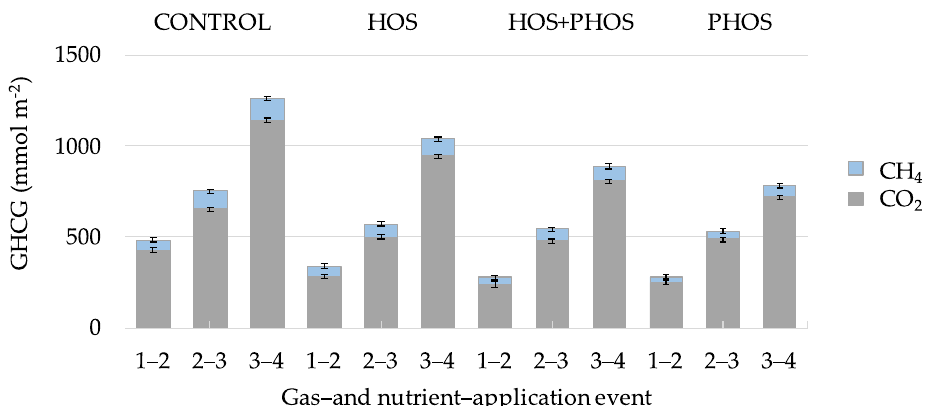
Figure 4. Emissions of CO 2 and CH 4 from experimental reactors from one gas- and nutrient application event to another. [Sed] = 14.1 g (dw) L − 1 ; [TOC] = 11,302 mmol m − 2 ; I = 2.6 mmol L − 1 ; T = 28.2 ± 1.5 °C; for Eh and pH values, see Table 5.